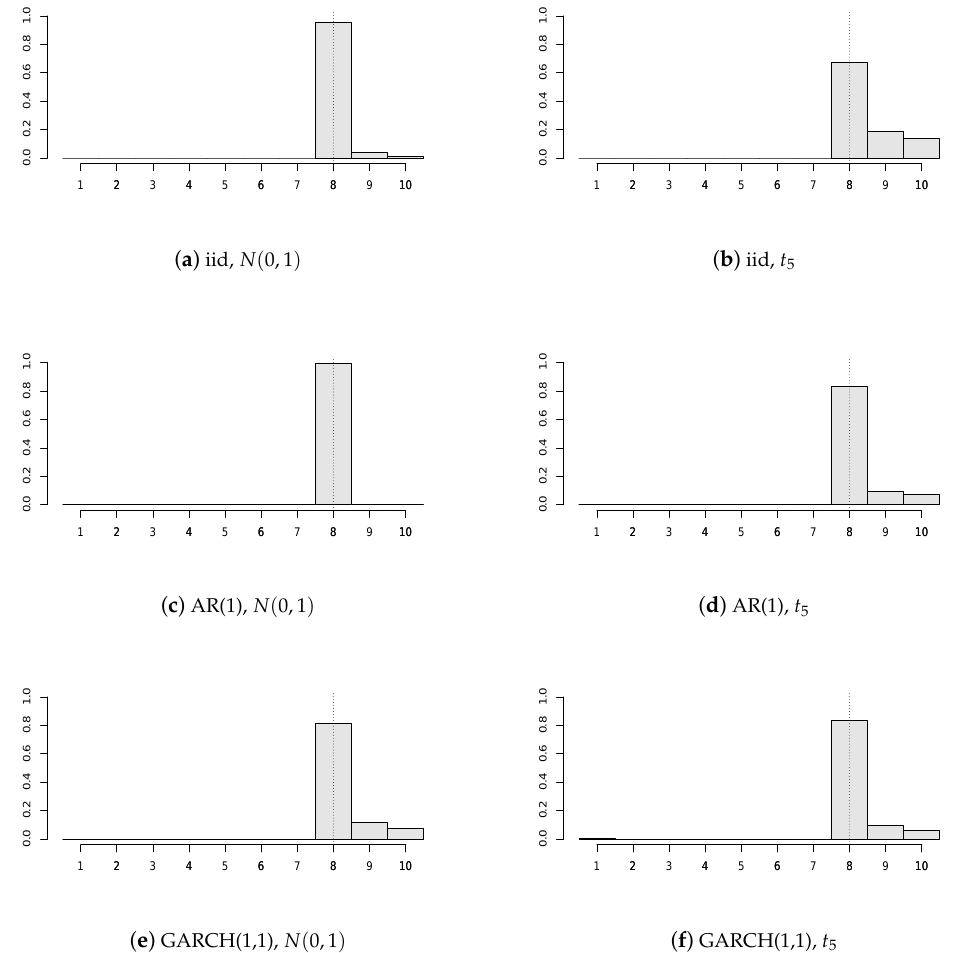
Figure 1. Histograms of the estimated change points (cid:98) τ N for various structures and distributions of the panel disturbances ( τ = 8, T = 10, N = 20, σ = 0.2; all of the panels are subject to a break of size δ i ∼ U [ 0,2 ]